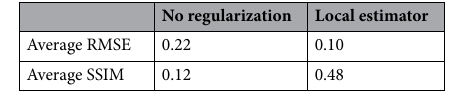
Table 6. Summary of results local estimator